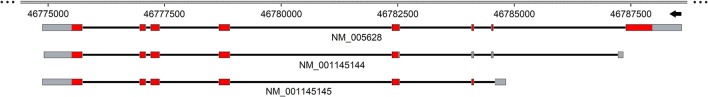
Schematic representation of human SLC1A5 gene. Exons and introns are depicted with solid boxes and black straight lines, respectively. UTR sequence is highlighted in gray while the coding region in red. Genbank accession number is reported below each of the transcripts. The scheme is realized using SnapGene tool.